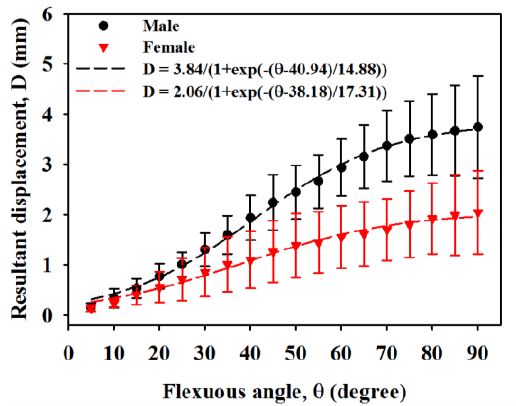
Figure 6. Resultant displacements of the MN in males and females while flexing fingers from 0° to 90°.